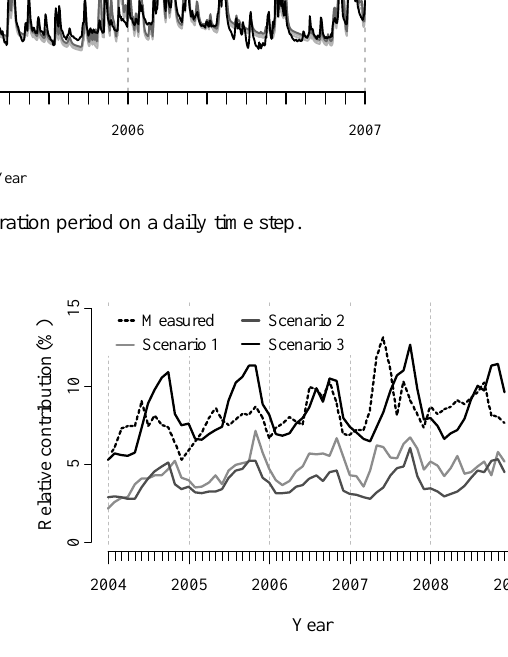
Fig. 11. Relative contribution (% monthly mean total flow) of the WWTPs to the total river flow. Measured refers to the empirical results obtained in Sect.